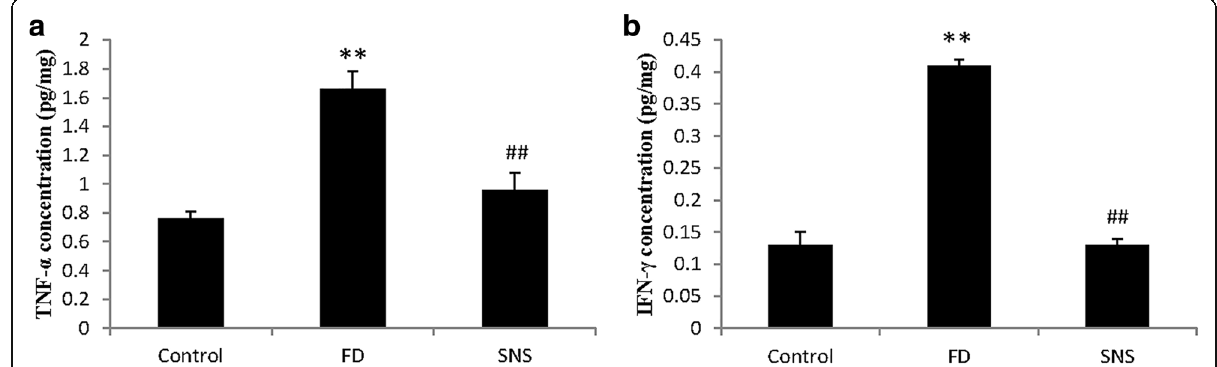
Fig. 5 Concentrations of TNF- α ( a ) and IFN- γ ( b ) in the duodenum. TNF- α and IFN- γ levels were remarkably higher in the duodenal mucosa of model group than the control group. The SNS group showed a lower level of expression of TNF- α and IFN- γ .. All data were expressed as mean ± SEM (6 rats in each group). ** P < 0.01 compared with the control group; ## P < 0.01 compared with the model group